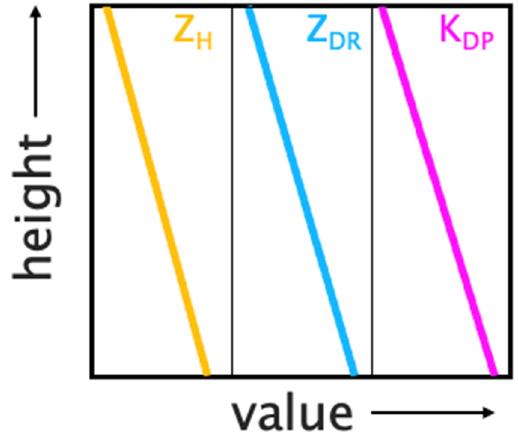
Figure 1. Graphical representation of microphysical “fingerprints” in vertical profiles of dual-polar- ization radar variables. Height is on the vertical axis, increasing upwards, whereas the value of each polarimetric radar variable increases from left to right along the abscissa. Each radar variable is shown in a subpanel, color-coded as follows: goldenrod for Z H on the left, cyan for Z DR in the middle, and magenta for K DP on the right. In this example, all three radar variables are seen to increase towards the ground.